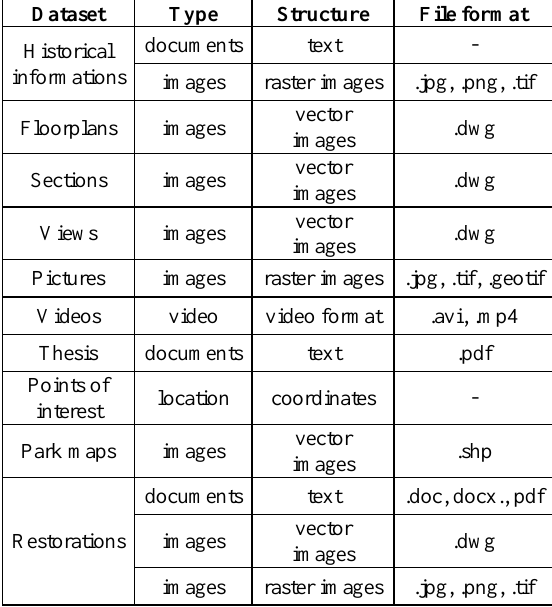
Table 1. List of datasets of Villa Revedin Bolasco Datasets contain also spatial information, and for this reason we adopted a geodatabase. To manage and explore these rich The structure of geodatabase is described in Figure 7.